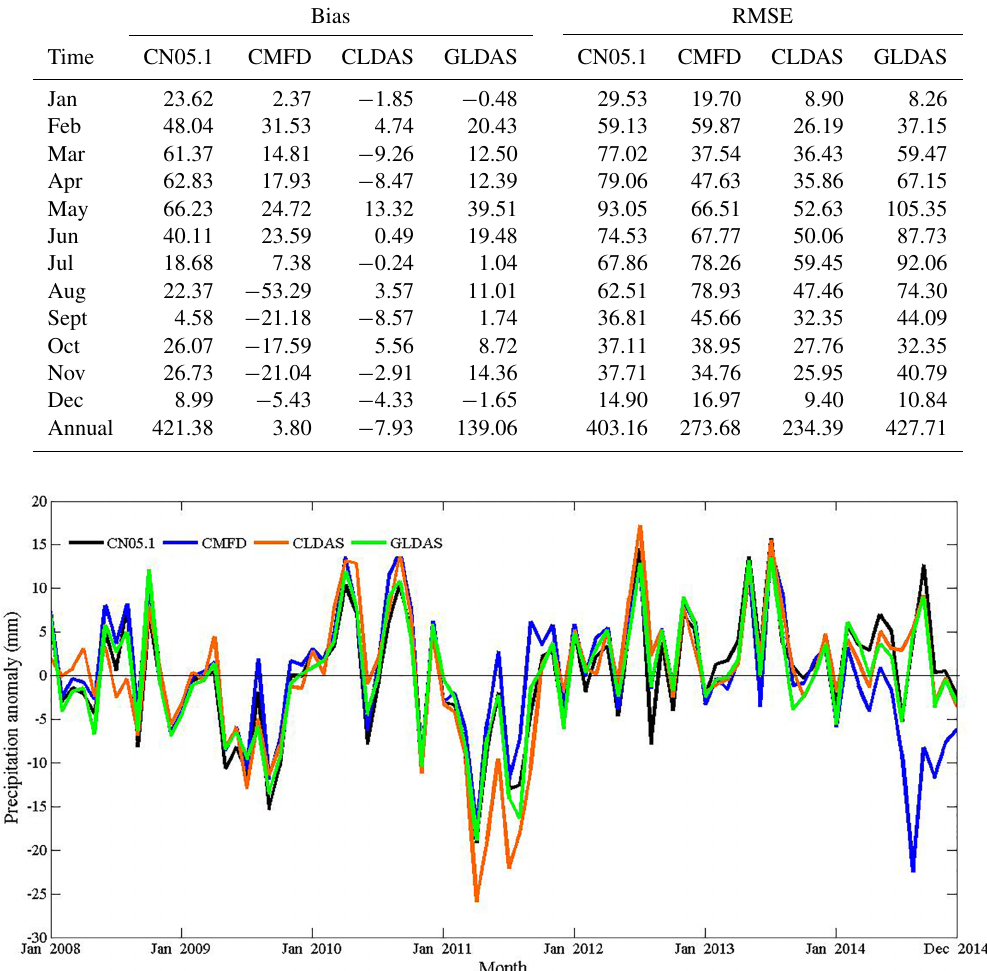
Figure 4. Time series of monthly mean precipitation anomalies from CN05.1 (black), CMFD (blue), CLDAS (orange) and GLDAS